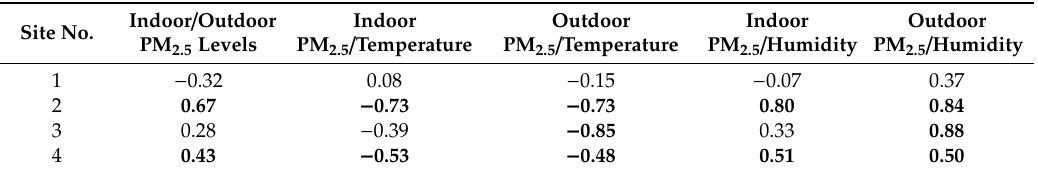
Table 3. The Spearman’s rank order correlation for 15-min averages of indoor and outdoor PM 2.5 levels, outdoor temperature and outdoor